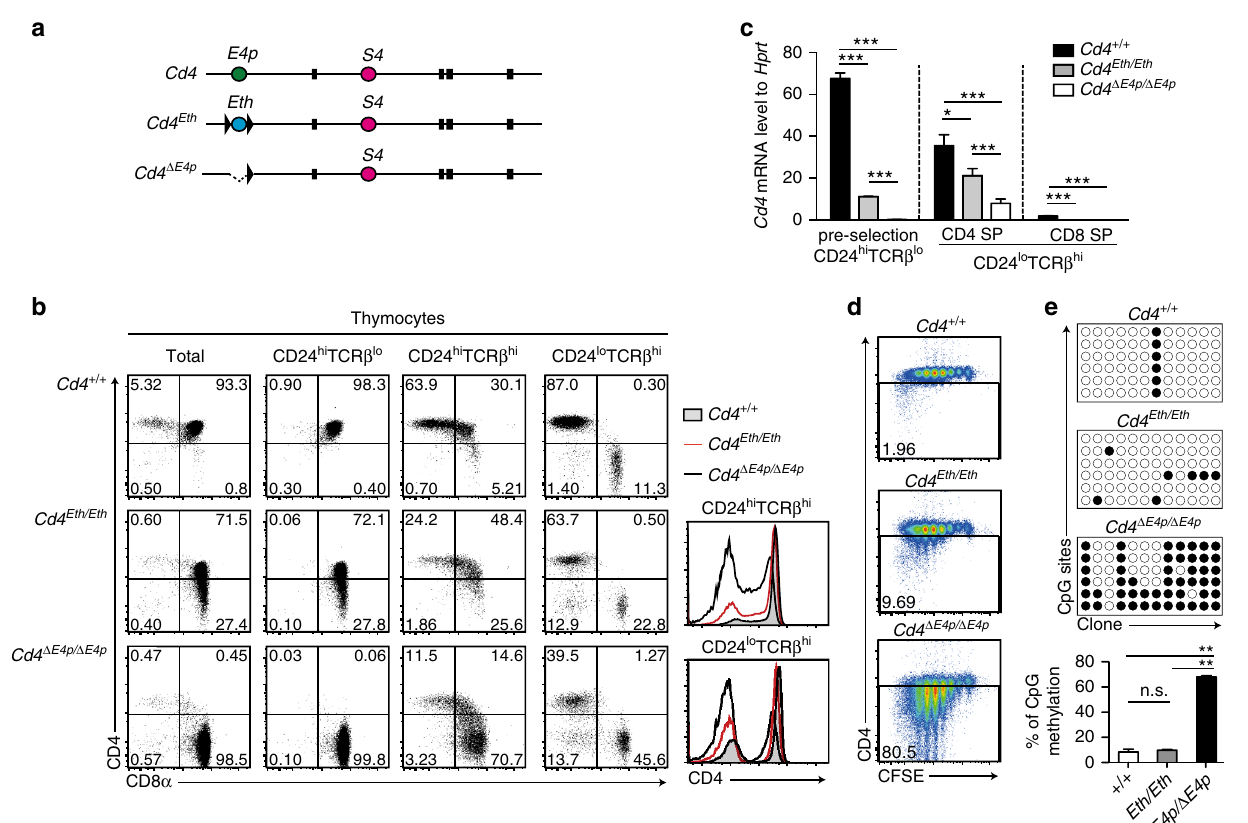
Fig. 1 Enhancer replacement between Cd4 and Thpok genes. a Schematic structures of mutant Cd4 alleles. Ovals marked with different colors represent c is - regulatory regions, Cd4 silencer ( S4 ), Cd4 proximal enhancer ( E4p ), and synthetic Thpok enhancer ( Eth ). The black box and triangle represent exons and loxP sequences, respectively. b Dot plots showing CD4 and CD8 expression and histograms at the right showing CD4 expression in indicated cell subsets from mice with indicated genotypes. Numbers in quadrants indicate respective cell percentage. Representative results of at least three independent analyses. c Graph showing relative Cd4 to Hprt mRNA in pre-selection CD24 hi TCR β lo thymocytes, CD24 lo TCR β hi CD4 single positive (SP), and CD24 lo TCR β hi CD8 SP thymocytes of mice with indicated genotypes. Means ± SD. *** p < 0.001, * p < 0.05 ((One-way ANOVA and Tukey ’ s